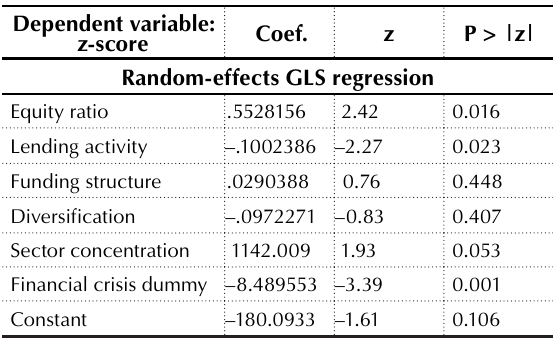
Table 2. Presentation of random-effects GLS regression results